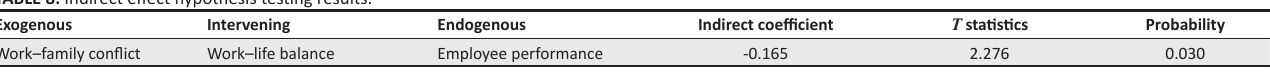
TABLE 8: Indirect effect hypothesis testing results.